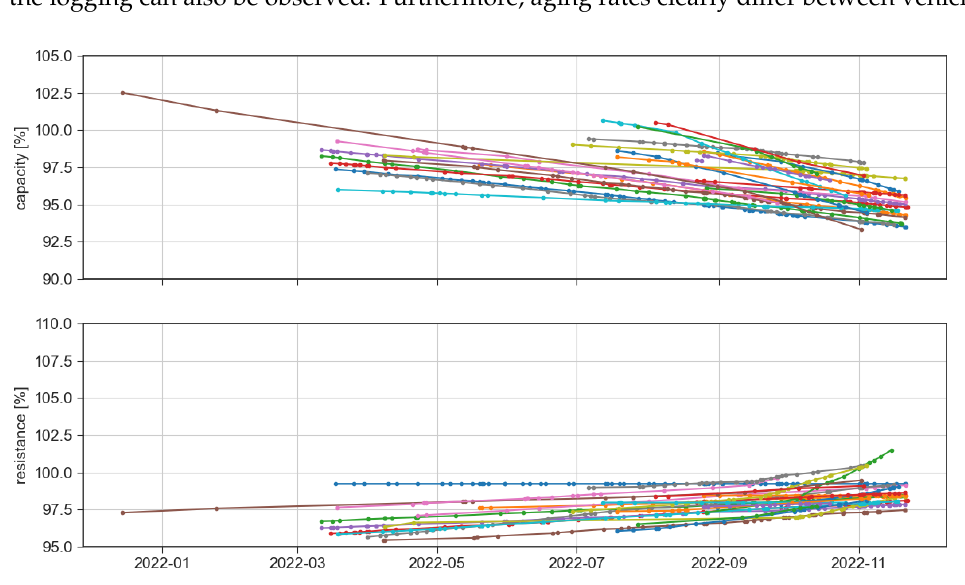
Figure 10. Estimated SOH scaling factors for capacity decrease and resistance increase for each device. Different colors distinguish the different devices. The figure shows the general SOH trend as well as the spread between devices.